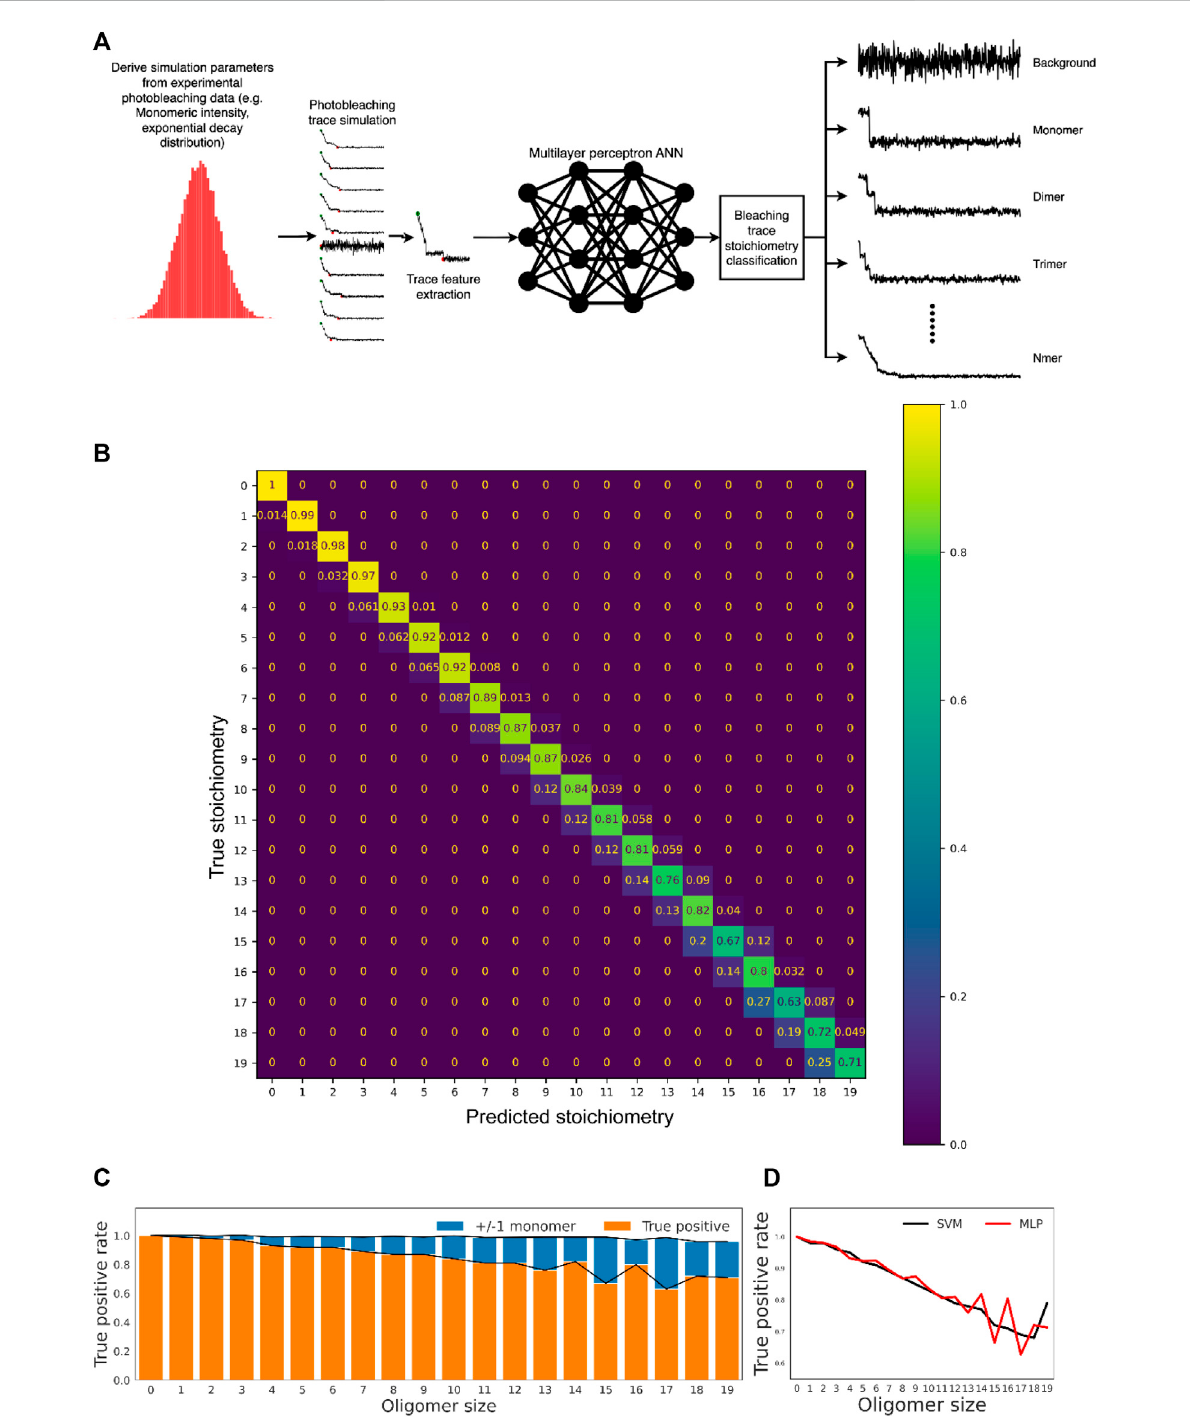
FIGURE 4 Machinelearning-basedclassi fi cationofrealisticphotobleachingtracesallowsaccuratedeterminationofoligomerstoichiometry. (A) Overview ofthecomputationalwork fl owemployedforoligomersubunitpredictionwithanMLPmodel. (B) ConfusionmatrixshowingperformanceoftheMLP model on the held-out test data. The scale indicates the fraction of each ground truth stoichiometric class predicted to have a given stoichiometry. (C) True positive rates for the model across all stoichiometric classes. “ Relaxed ” true positive rates are also shown, where classi fi cation is considered correct if the classi fi cation is only ± 1 monomeric unit from the true value. The average relaxed true positive rate across all classes